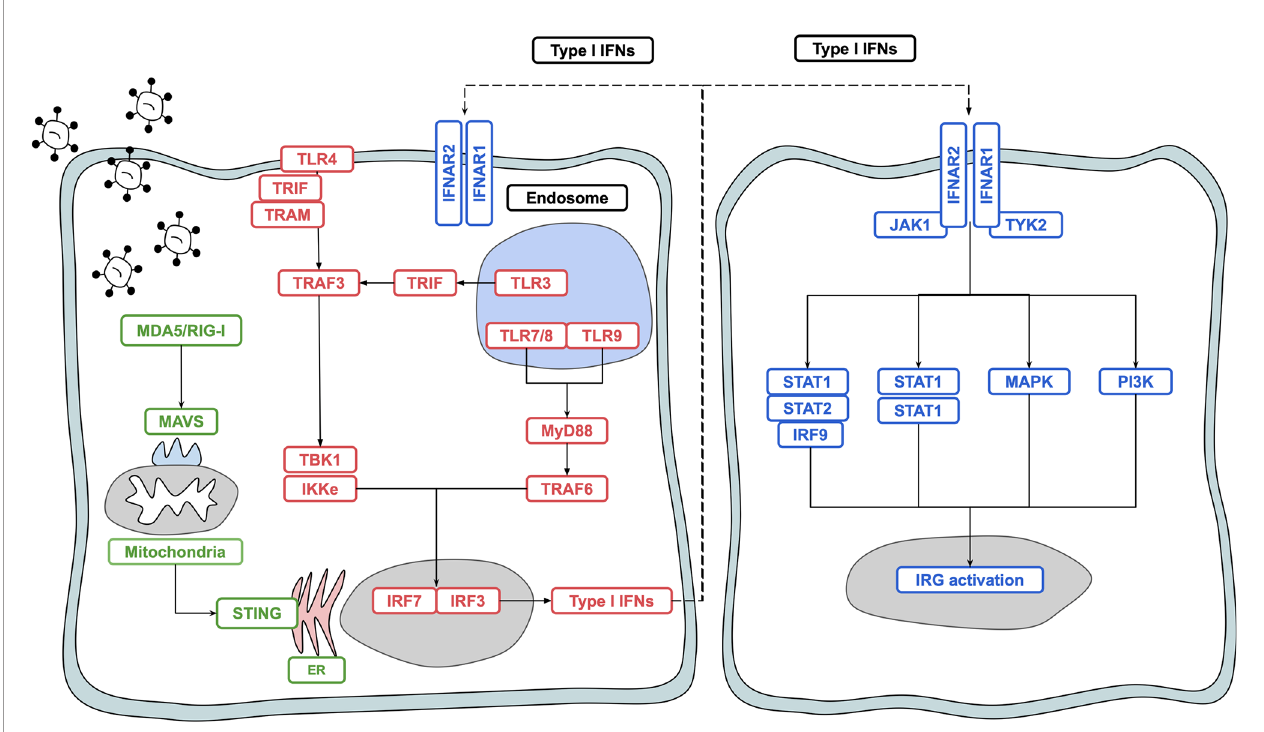
FIGURE 1 | Overview of type I interferon induction and signalling. Activation of PRRs such as TLR4, TLR3, TLR7, TLR8 and RIG-I results in signal transduction and activation of the transcription factors IRF3 and IRF7, leading to production of IFN-I. IFN-I binds to the IFNAR1/IFNAR2 heterodimer and signals in both a paracrine and autocrine manner via the JAK/STAT pathway to upregulate interferon regulated genes which act to protect the host against noxious agents such as viruses and